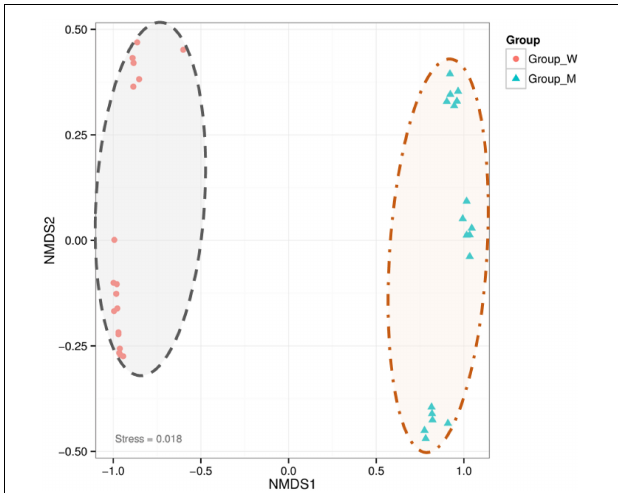
FIGURE 2 | Non-metric multidimensional scaling (NMDS) comparison of bacterial communities in the different treatment groups. The group W represents unsterilized treatment sample in graph and the group M represents sterilized treatment sample in